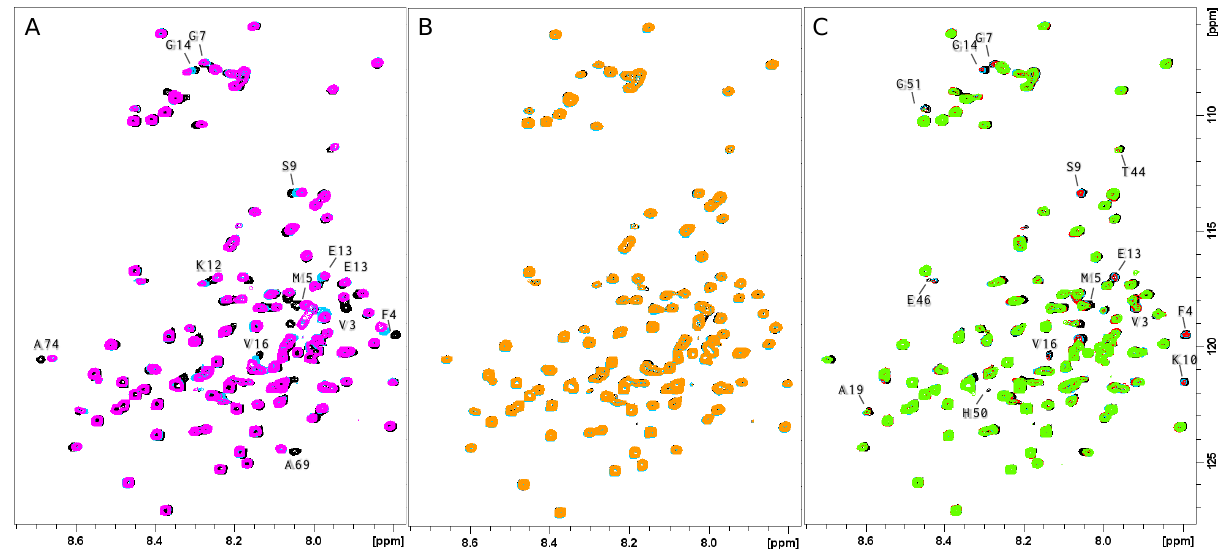
Figure 1. Overlaid 1 H- 15 N HSQC spectra of micelle- bound αSyn 1 – 140 ( 15 N uniformly enriched) in the presence of increasing amounts of metal ion: ( A ) 0 eq (black), 0.3 Ag + equiv. (light blue), 0.6 Ag + equiv. (magenta); ( B ) 0.6 Ag + equiv. (black), 0.8 Ag + equiv. (light blue), 1 Ag + equiv. (orange); ( C ) 0 eq (black), 0.2 Cu 2+ equiv. (light blue), 0.4 Cu 2+ equiv. (red), 0.6 Cu 2+ equiv. (green). αSyn 1 – 140 240 μM, SDS-d 25 50 mM, phosphate buffer 20 mM pH= 7.4, T =298 K.